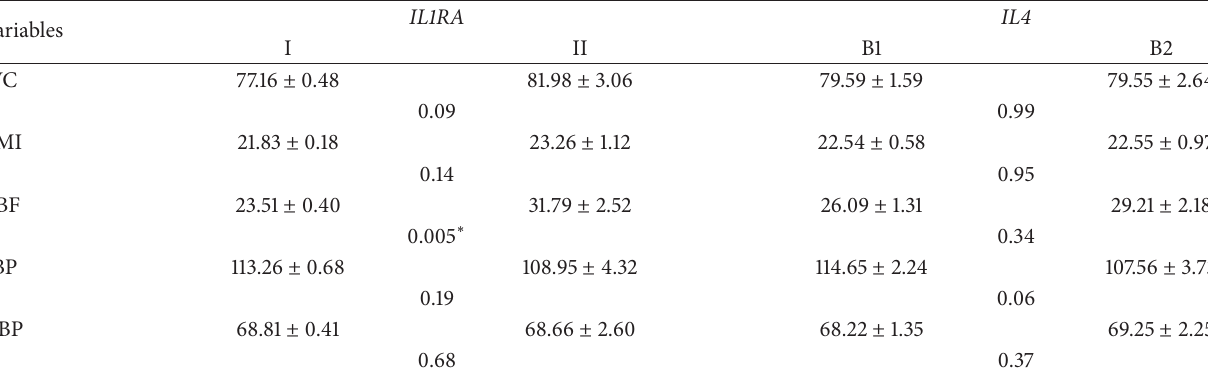
Table 4:Adjusted meansofoverall population’s anthropometricmeasurementsand bloodpressuresfordifferent IL1RA and IL4 VNTRalleles. Variables